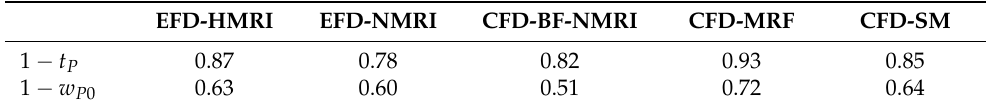
Table 7. Parameters of resistance and self-propulsion tests obtained from experiments and